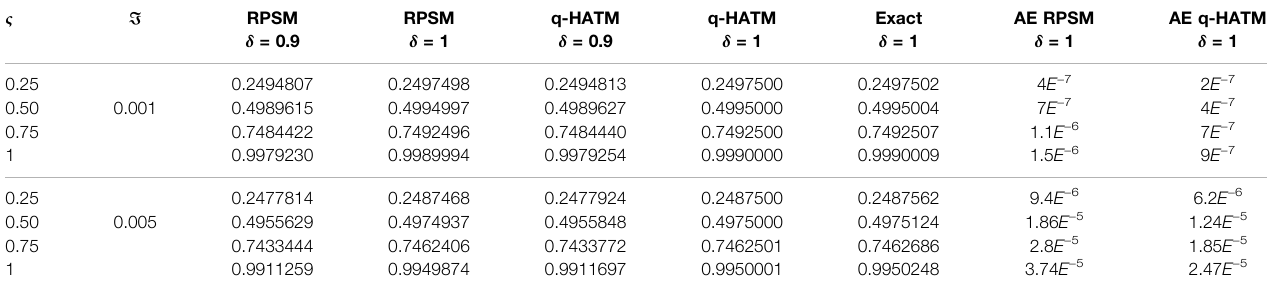
TABLE 3 | A comparison of RPSM, q-HATM and exact for various values of ς and I . ς I RPSM δ =